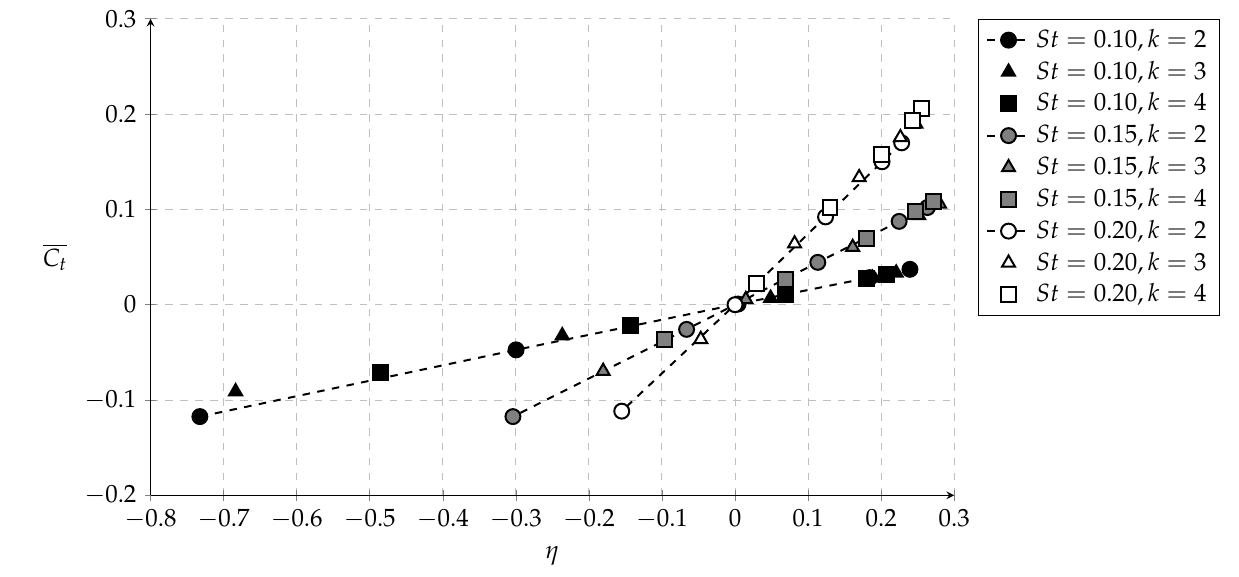
Figure 12. C t as a function of η at St = 0.10, St = 0.15 and St = 0.20.